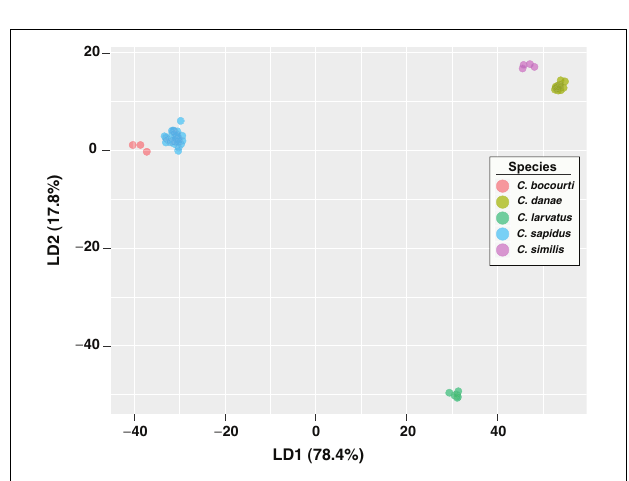
FIGURE 5 | LDA plot of HRM curves for Callinectes spp. samples. Classification results are shown for the first two LD functions from a single LDA model, randomly using half of the data for training and the other half for validation/prediction. Each axis displays the proportion of the variance accounted for by a discriminant function (LD1 or LD2), relative to the total variance.